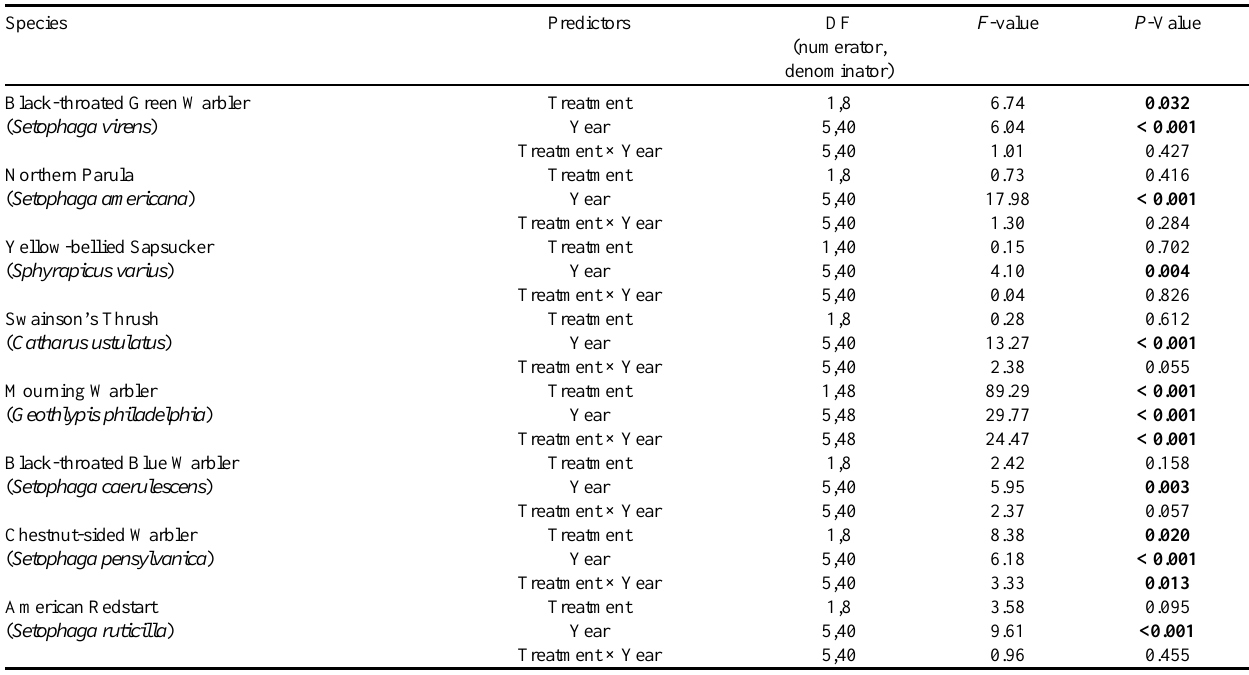
(numerator, denominator)